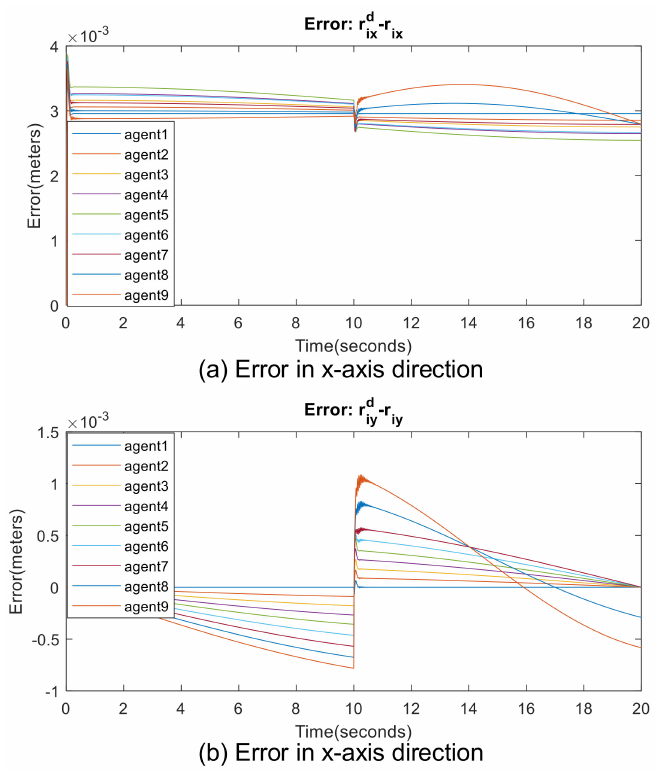
Figure 24. Errors between the real position and the desired position of the